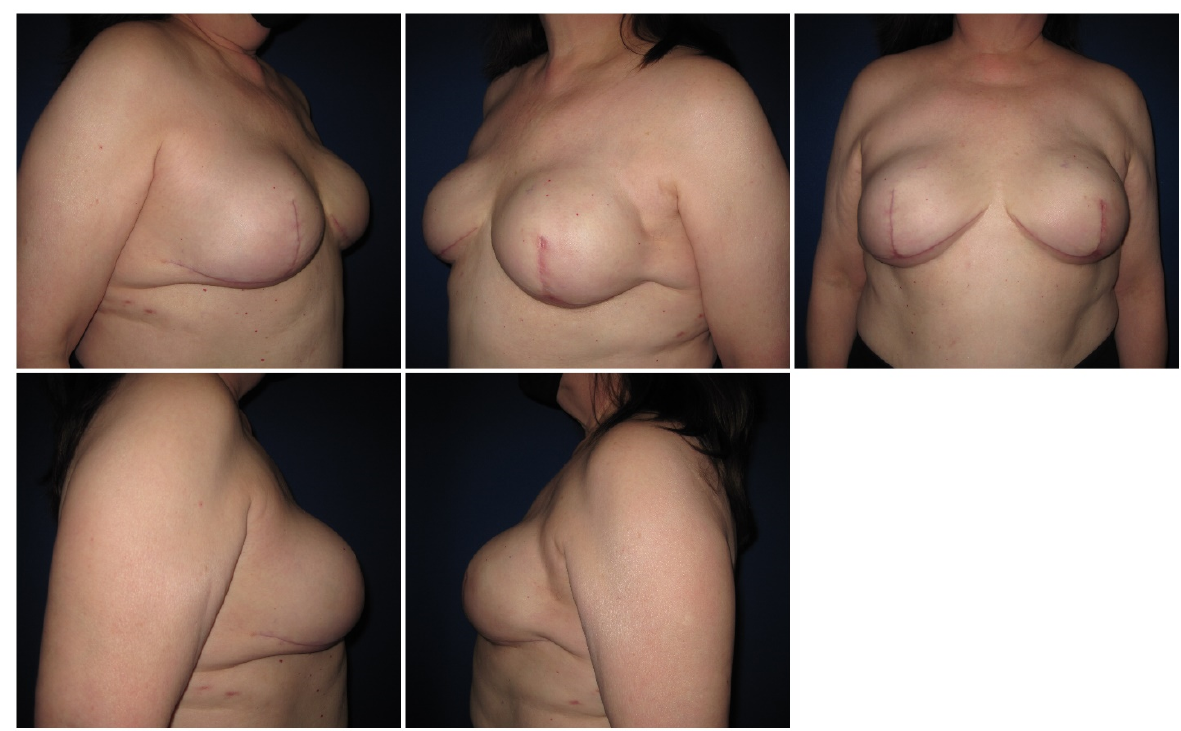
Figure 4. Post-operative pictures, 3 months after surgery.